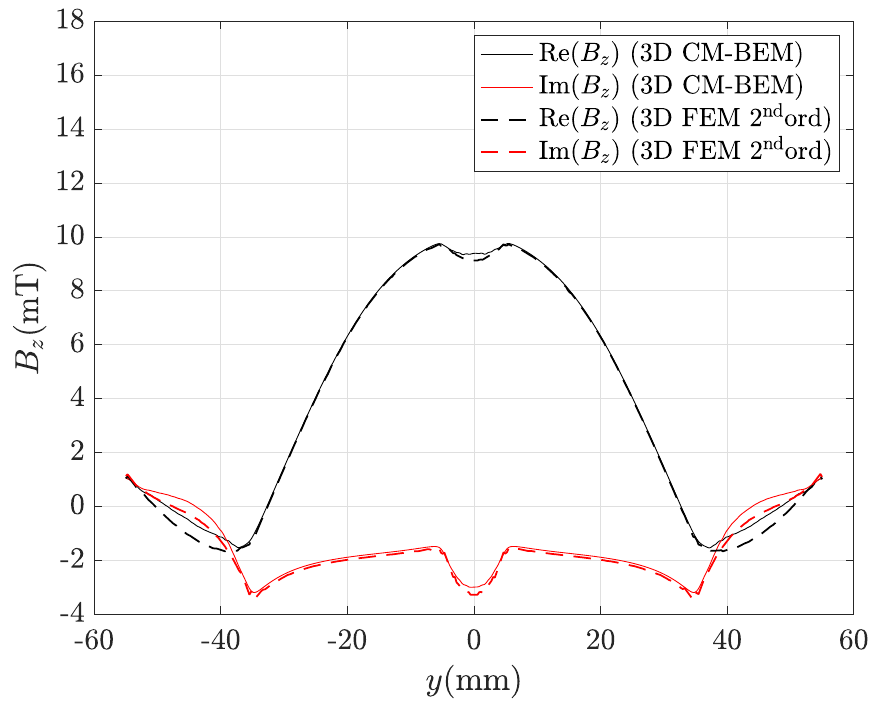
Figure 16. Real and imaginary parts of the magnetic flux density radial component B z along line AB depicted in Figure 8 computed by the hybrid method (ACA matrix compression) with the finest mesh (435,213 tets): CM-BEM is the straight line, second ord. 3D FEM (reference) is the dashed line.